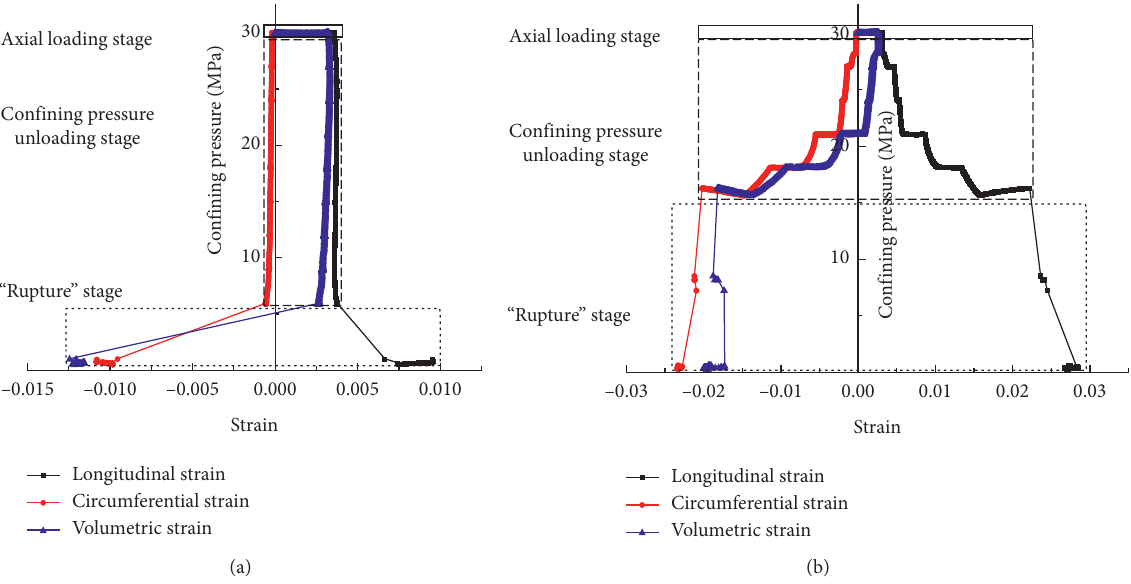
Figure 8: Confining pressure versus strain curve for the mudstone specimens. (a) Depth � 200m.(b) Depth �